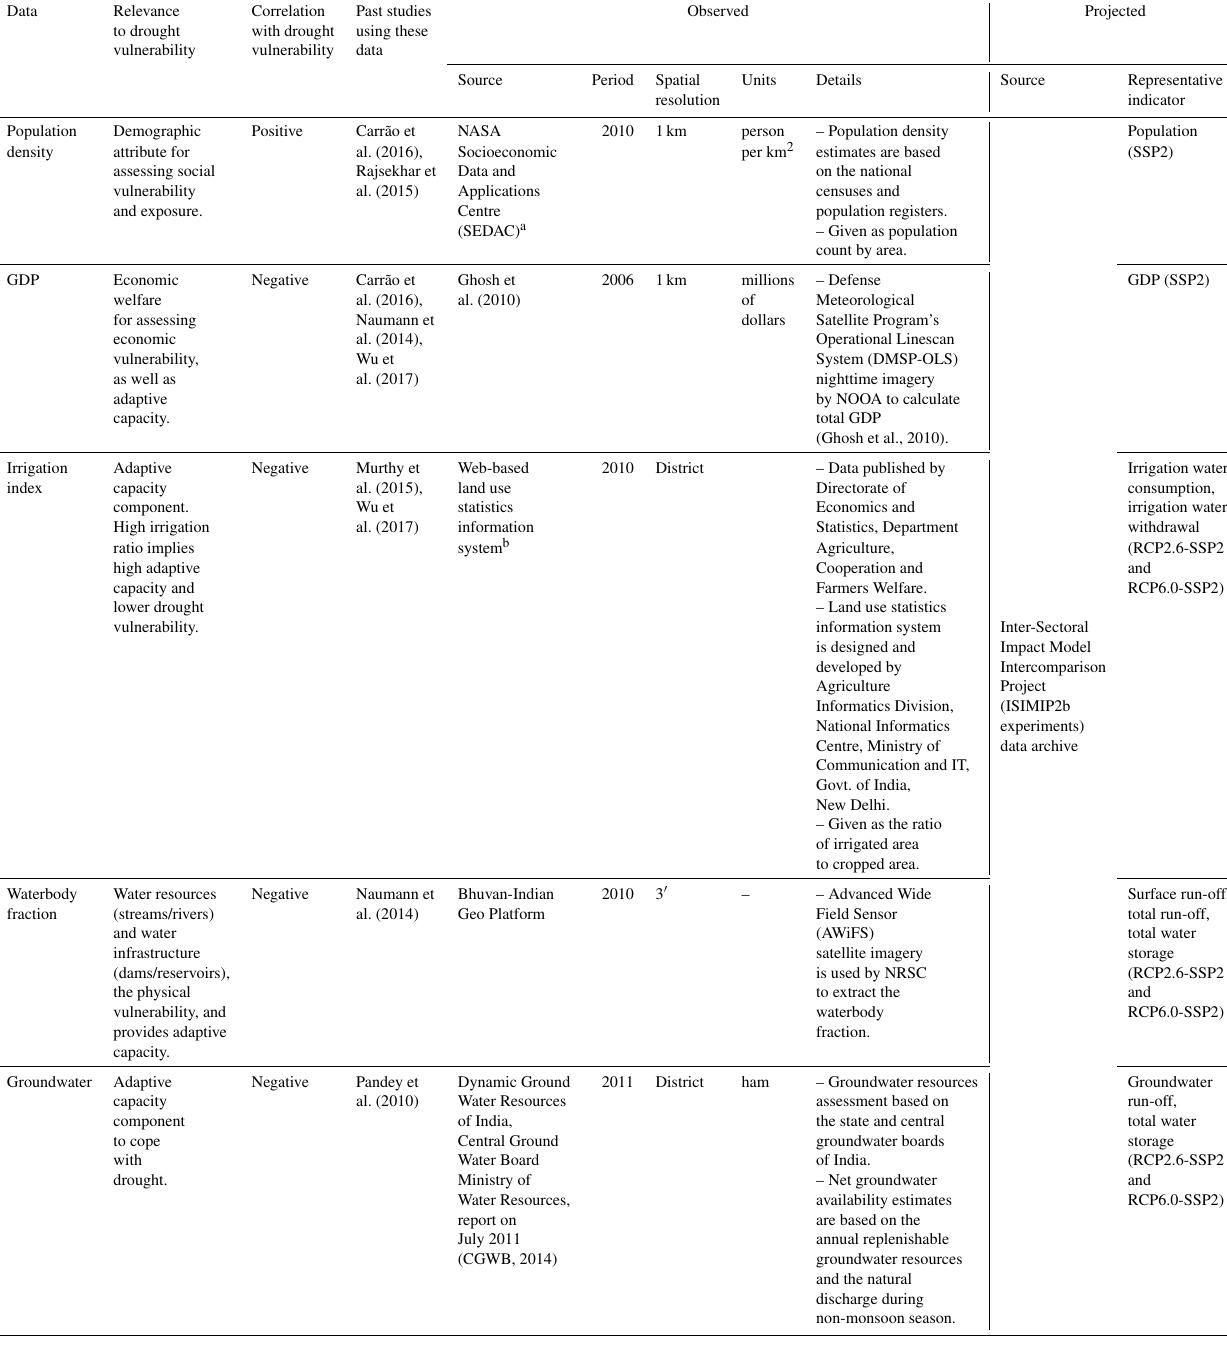
Table 1. Drought vulnerability indicators used for drought vulnerability assessment. The sources for indicators in the baseline period and the projected period along with their relevance and correlation with drought vulnerability are presented. Representative indicators to arrive at the drought vulnerability indicators for projected period are also